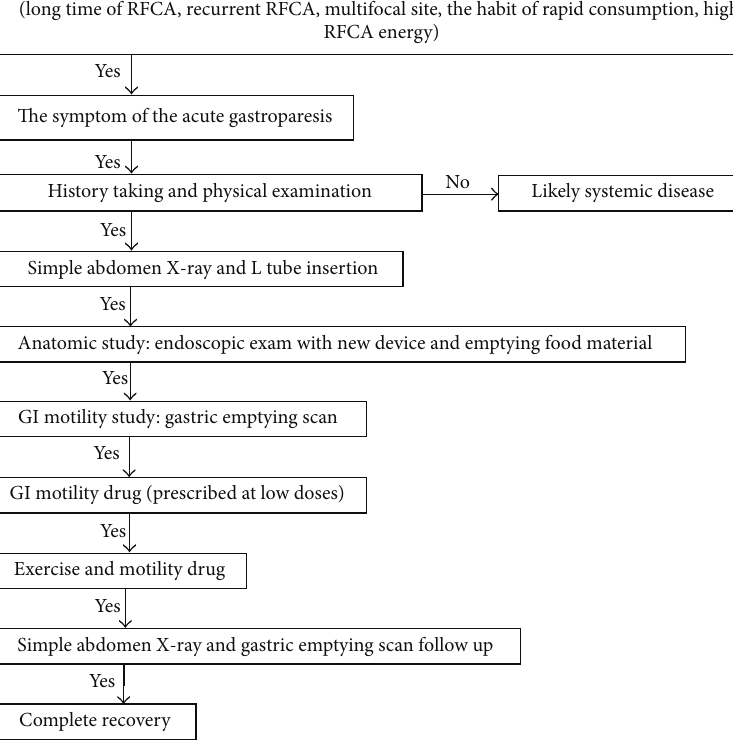
Figure 3: Flow chart of the diagnosis and treatment in our case and previous other